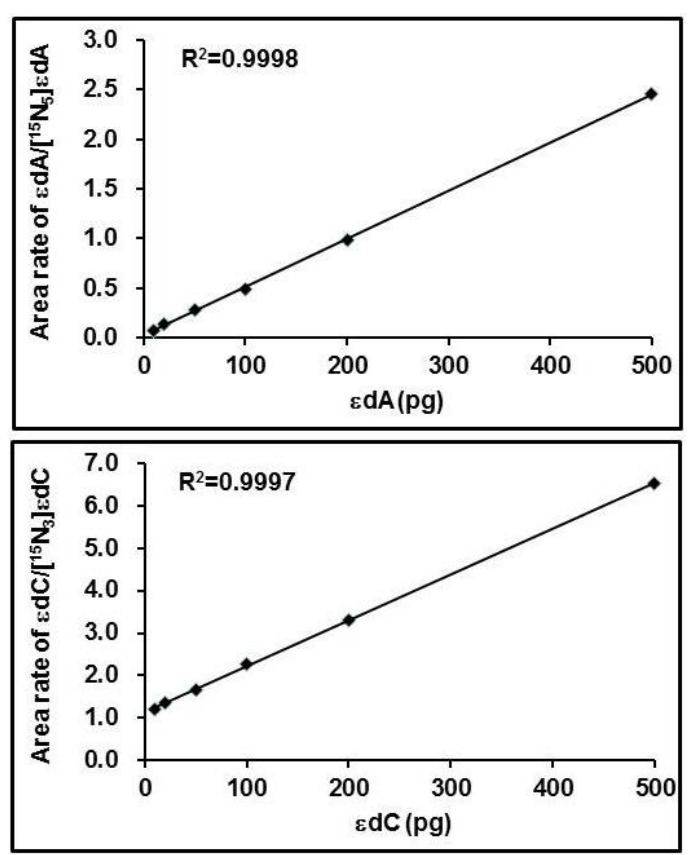
Figure 2. The substrate concentration-dependent response curve of the substrate (quantities of εdA and εdC) and the area ratios of εdA/[ 15 N 3 ]-εdA and εdC/[ 15 N 3 ]-εdC by UPLC-MS- MS